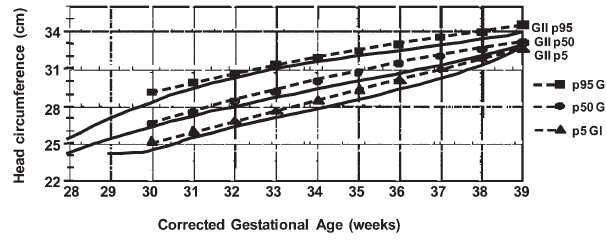
Figure 3 - Estimated values of 5 th , 50 th and 95 th percentiles of GI and GII VLBWI Head Circumference (HC in cm).